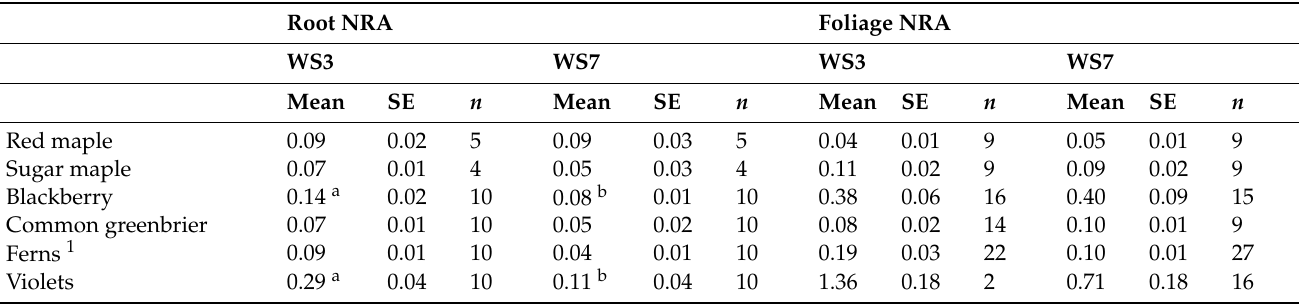
Table 3. Root and foliage NRA ( µ mol g − 1 h − 1 ) of overstory maple species and common herb-layer species collected in fertilized watershed (WS) 3 and unfertilized WS7 at the Fernow Experimental Forest, West Virginia, USA. Values for foliage NRA are from the sampling event closest to the root sampling event (i.e., midsummer 2019). Fern foliage n exceeds the number of plots per watershed (18) because multiple fern species were combined for the analyses. Across all species, root NRA was greater in fertilized WS3 than unfertilized WS7. Differences between foliage and root NRA were also statistically significant for each species (see Table 4).